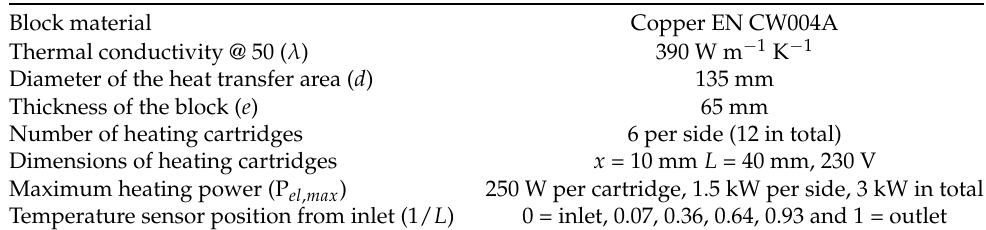
Figure 3. Flow sheet and instrumentation diagram of the experimental test setup used in the investi- gation. Table 4. Specifications of the measuring section (heating block as shown in the picture in Figure 4) used in the experimental